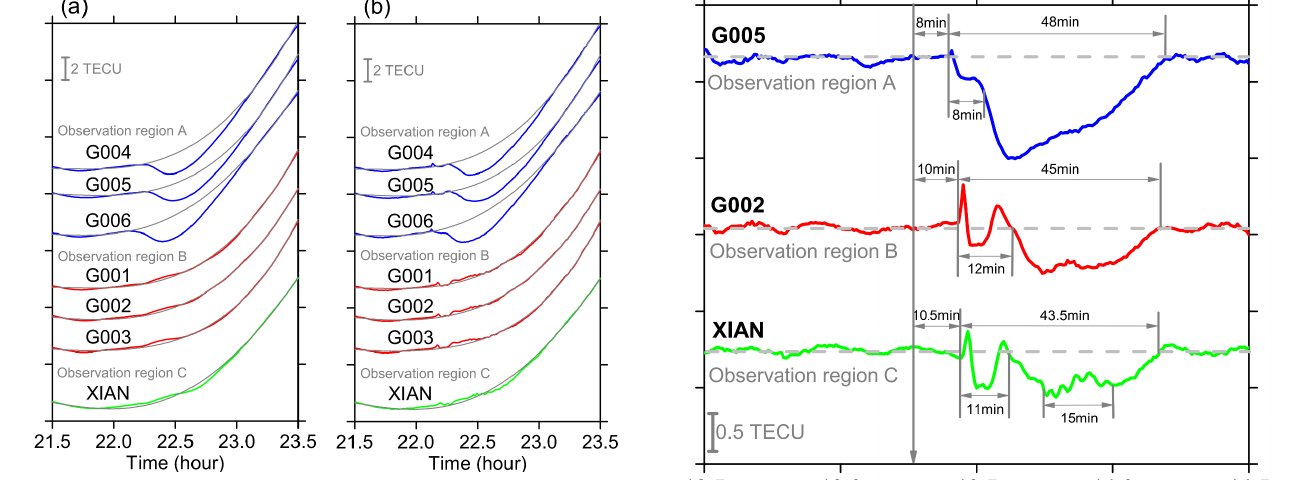
Figure 6. (a) The color curves represent the low frequency part of filtered ionospheric STEC time series for satellite PRN16 of all the seven GPS stations on the day of Shenzhou-8 launch (DOY = 304) in three observation regions A, B and C by setting a cutoff period of 12min, the grey curves represent reference curves calculated by least squares polynomial method for the filtered ionospheric STEC time series; (b) the color curves represent the raw ionospheric STEC time series for satellite PRN16 of all the seven GPS stations on the day of Shenzhou-8 launch (DOY = 304) in three observation regions A, B and C, the grey curves represent also the reference curves calculated by least squares polynomial method for the fil- tered ionospheric STEC time series.